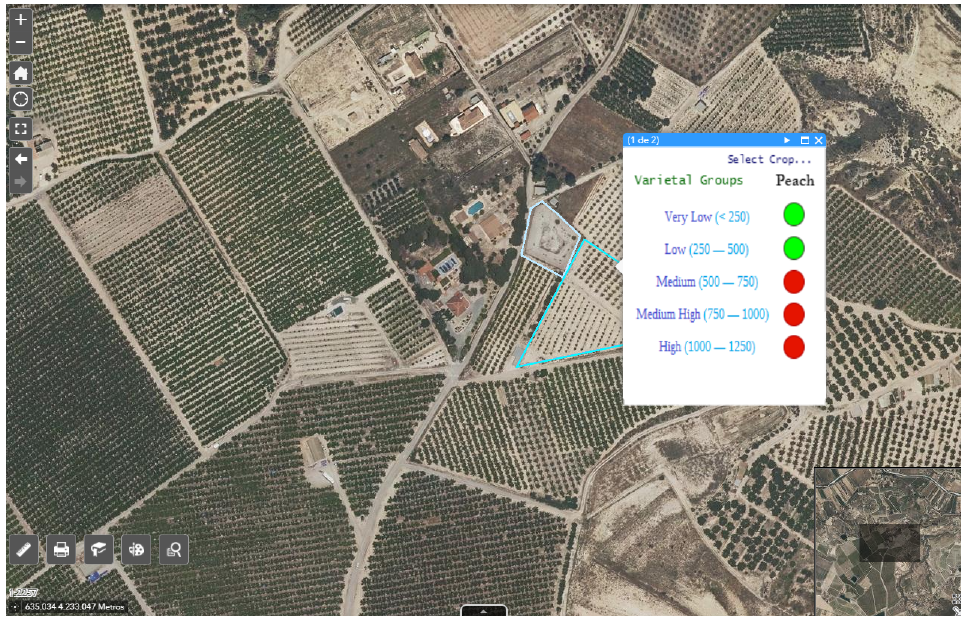
Figure 13. Geographic viewer showing the recommendation for planting varietal groups in an area. Another functionality, more oriented to the farmer, shows throughout the current week the historical and current climatological evolution of the selected area and the data of cold requirements (Portions and Cold Units) as shown in Figure 14. Furthermore, it shows the probability of frost or anomalous events, which improves productivity and avoids economic losses due to not meeting the selected variety’s cold requirements in the chosen